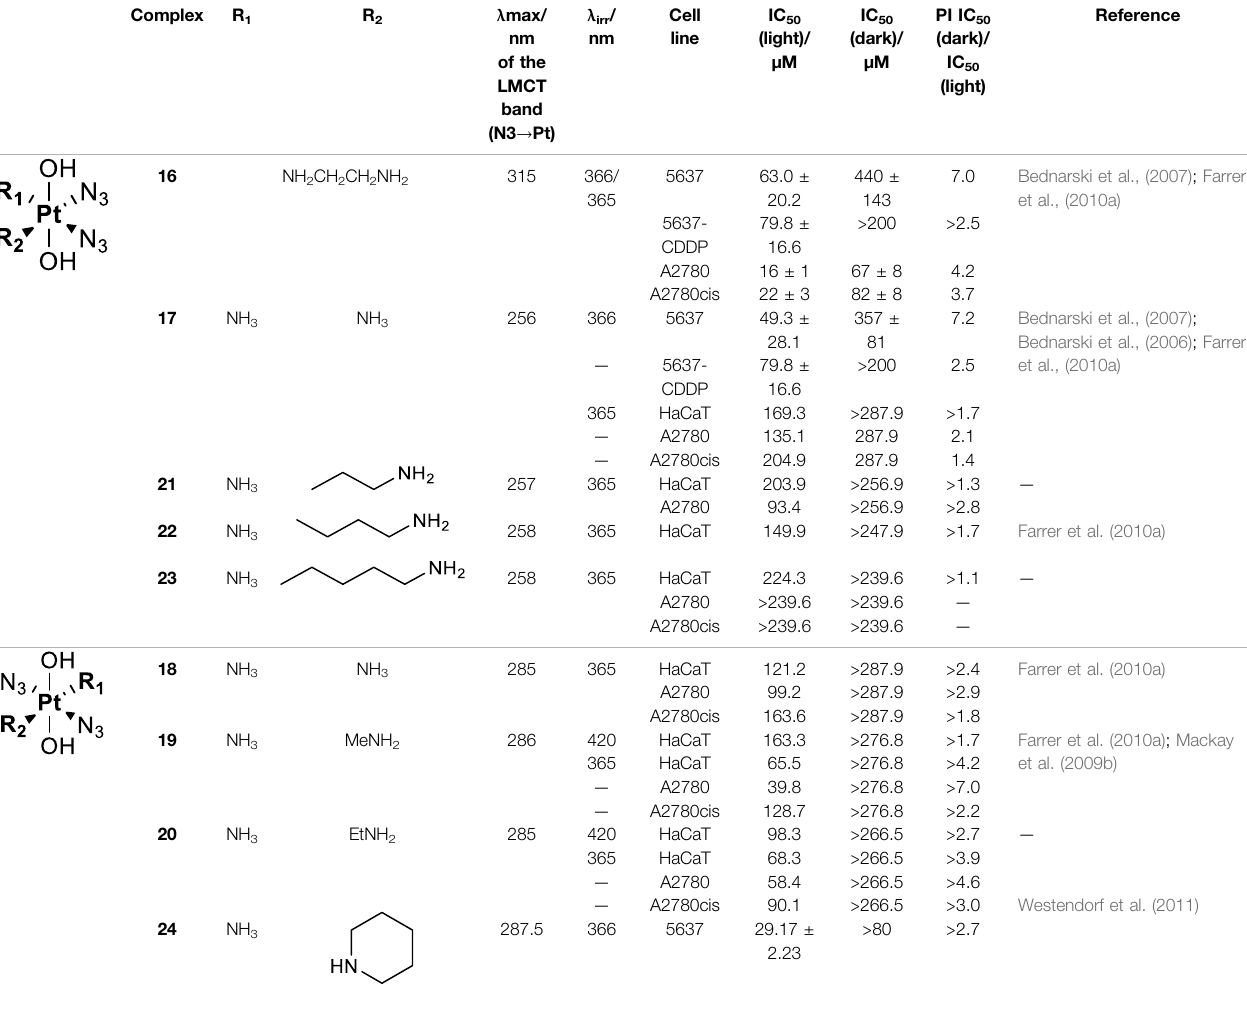
The bold values represent the numbering of the